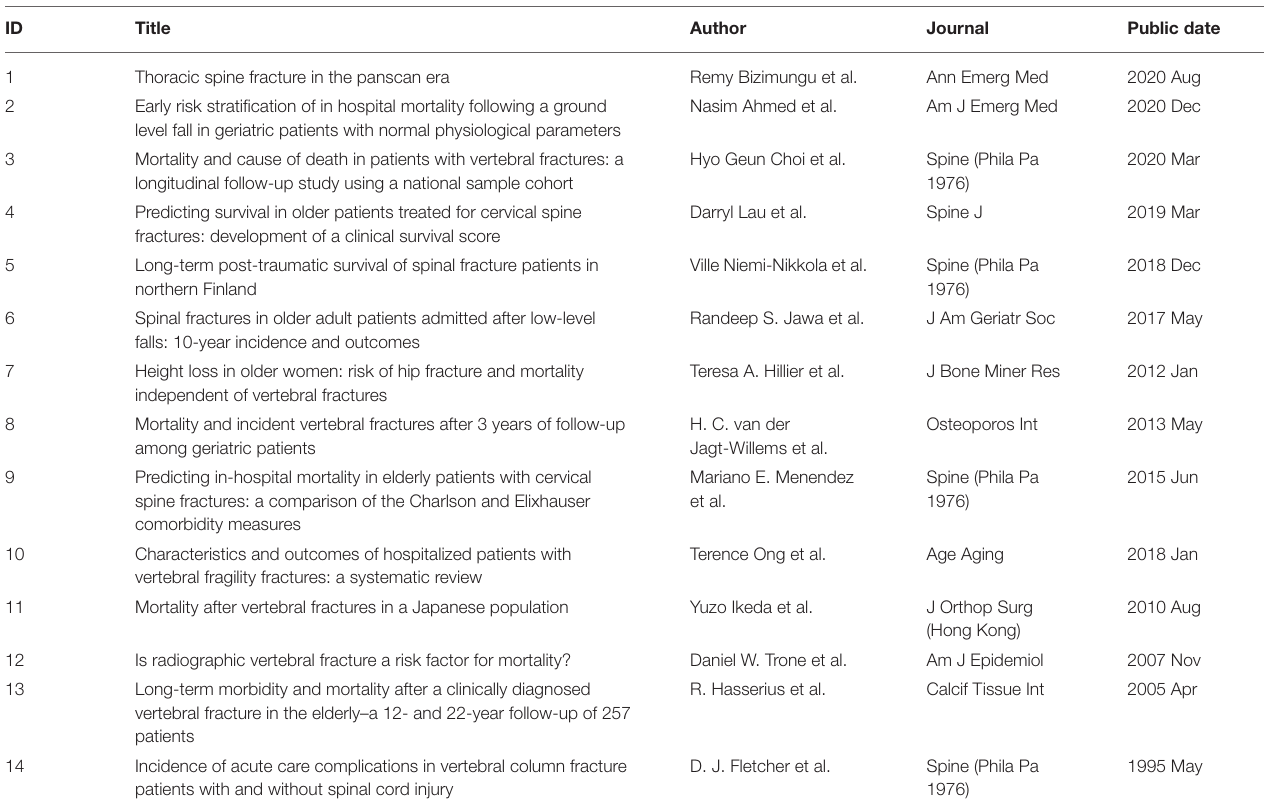
TABLE 3 | The summary of the previous related